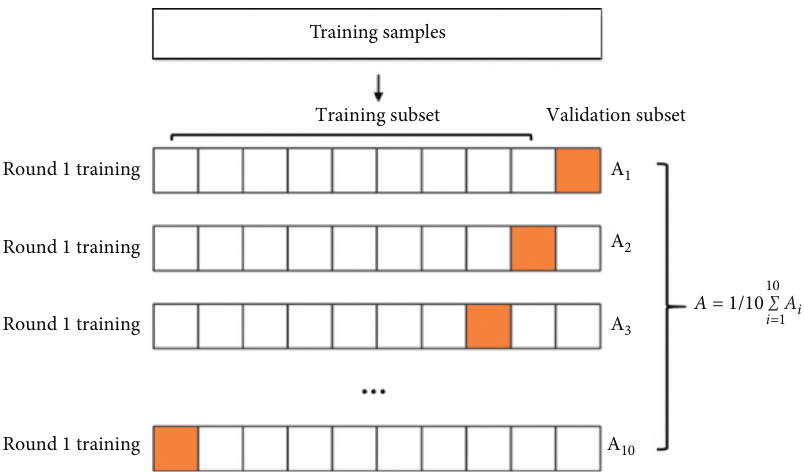
Figure 1: Schematic diagram of the 10-fold cross-validation process of the model.